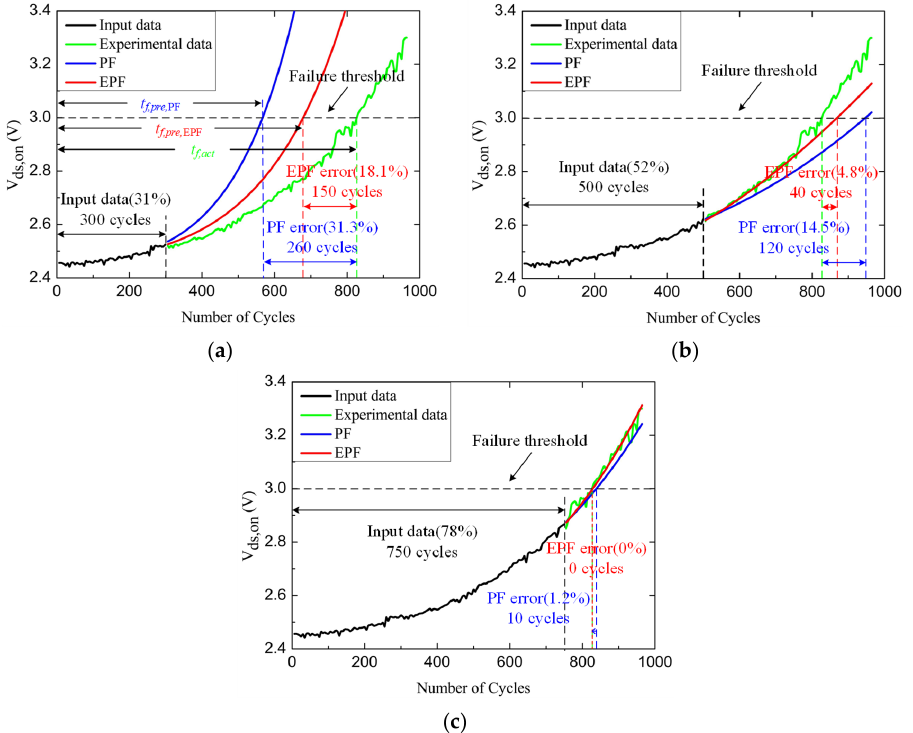
Figure 12. The prediction results for different amounts of input data. ( a ) 31% input data. ( b ) 52% input data. ( c ) 78% input data.